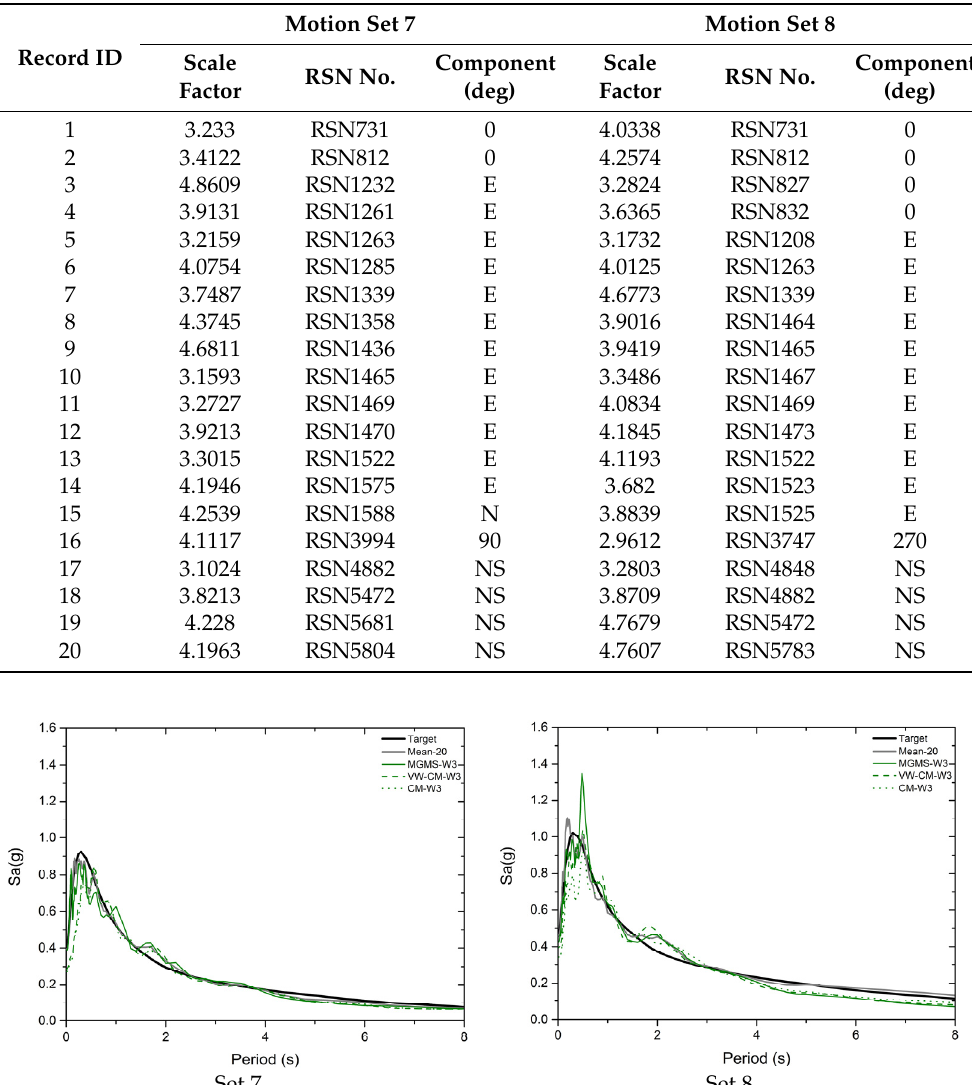
Figure A6. Mean spectra of IGMs selected from motion sets 7 and 8 with different selection procedures.